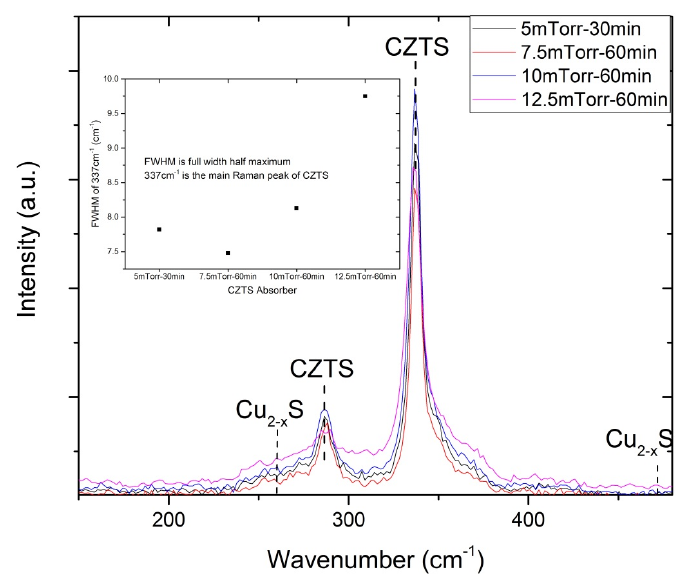
Figure 4. Raman spectra of CZTS absorbers fabricated from varying precursors: 5 mTorr ‐ 30 m, 7.5 mTorr ‐ 60 min, 10 mTorr ‐ 60 min, and 12.5 mTorr ‐ 60 min. The inlet picture shows the full width